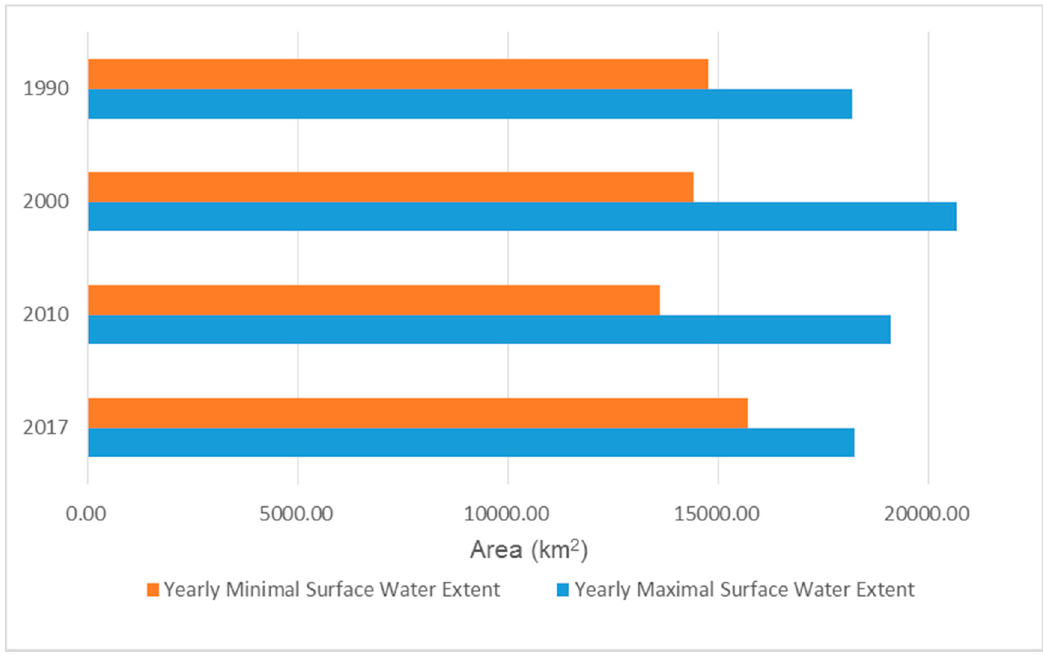
Figure 7. Yearly minimal and maximal surface water extent.